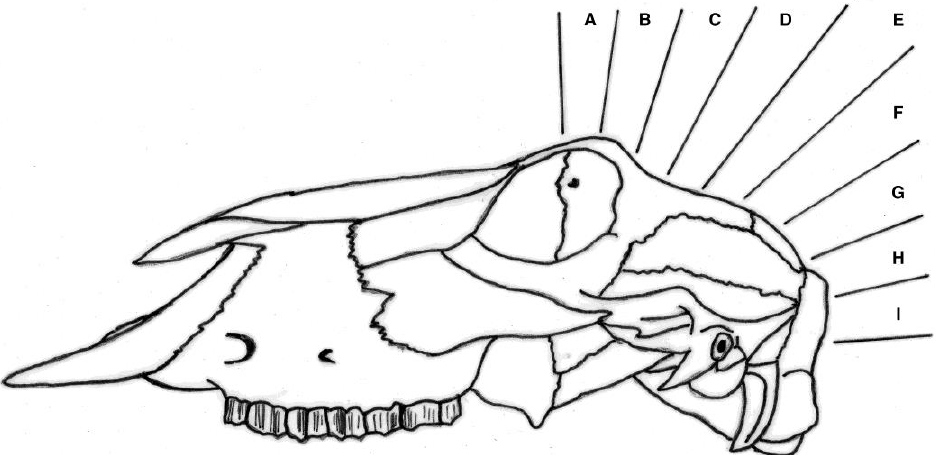
Figure 3. Diagram of lateral target area, with 0 representing the midline based on the suture of the paired frontal bones, L figures being to the left and R figures being to the right of this midline.